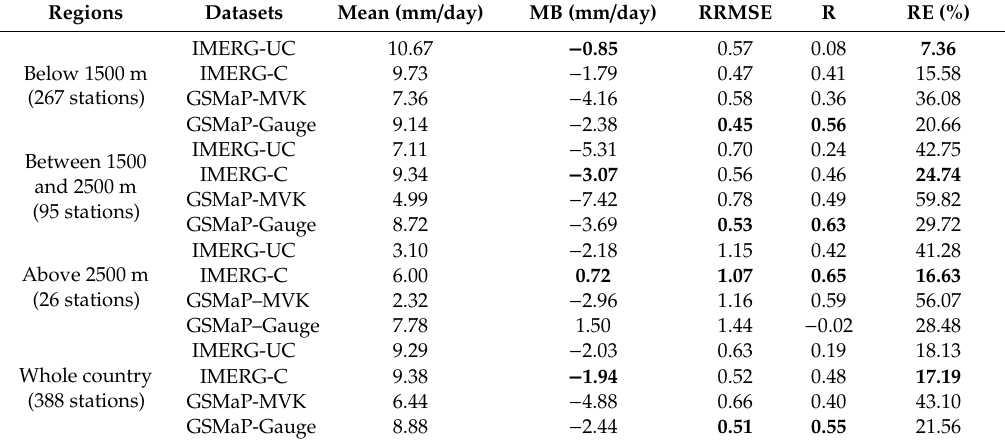
Table 5. Statistical metrics in the station mean precipitation at di ff erent elevation intervals (below 1500 m, between 1500 and 2500 m and above 2500 m), as well as in the whole study region, derived from the four SBP datasets and compared to the gauge observations during the summer monsoon for the study period. Bold font indicates the dataset with the best performance for a given